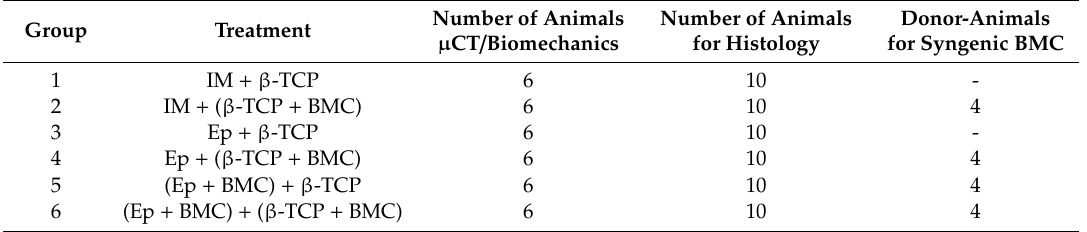
Table 1. Experimentaldesignandgroupset-up. IMinducedmembrane,BMCbonemarrowmononuclearcells. Group Treatment